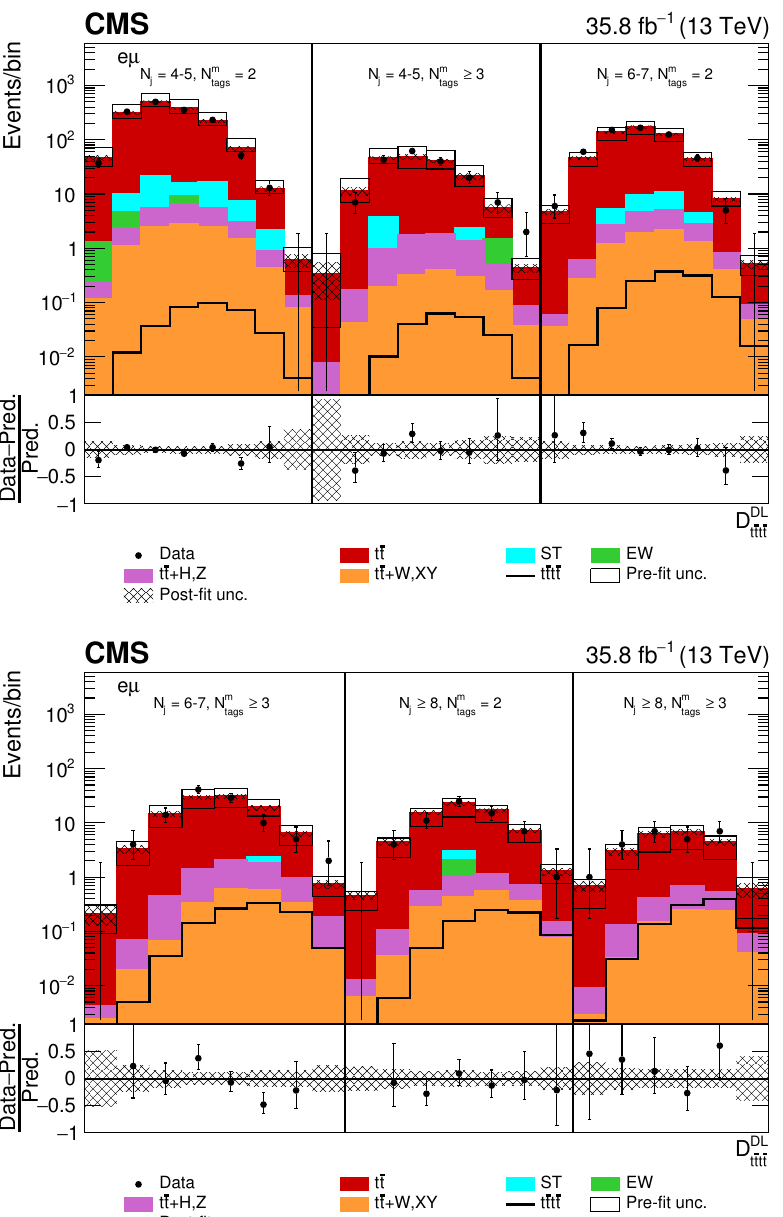
Figure 11 . Post-(cid:12)t D DL distributions in the (cid:22) (cid:6) e (cid:7) channel for events satisfying baseline opposite- tttt sign dilepton selection and (upper row) N = 4{5, N m = 2, (cid:21) 3, N = 6{7, N m = 2 and (lower j tags j tags row) N = 6{7, N m (cid:21) 3, N (cid:21) 8, N m = 2, (cid:21) 3. Dots represent data. Vertical error bars j tags j tags show the statistical uncertainties in data. The post-(cid:12)t background predictions are shown as shaded histograms. Open boxes demonstrate the size of the pre-(cid:12)t uncertainty in the total background and are centered around the pre-(cid:12)t expectation value of the prediction. The hatched area shows the size of the post-(cid:12)t uncertainty in the background prediction. The signal histogram template is shown as a solid line. The lower panel shows the relative di(cid:11)erence of the observed number of events over the post-(cid:12)t background